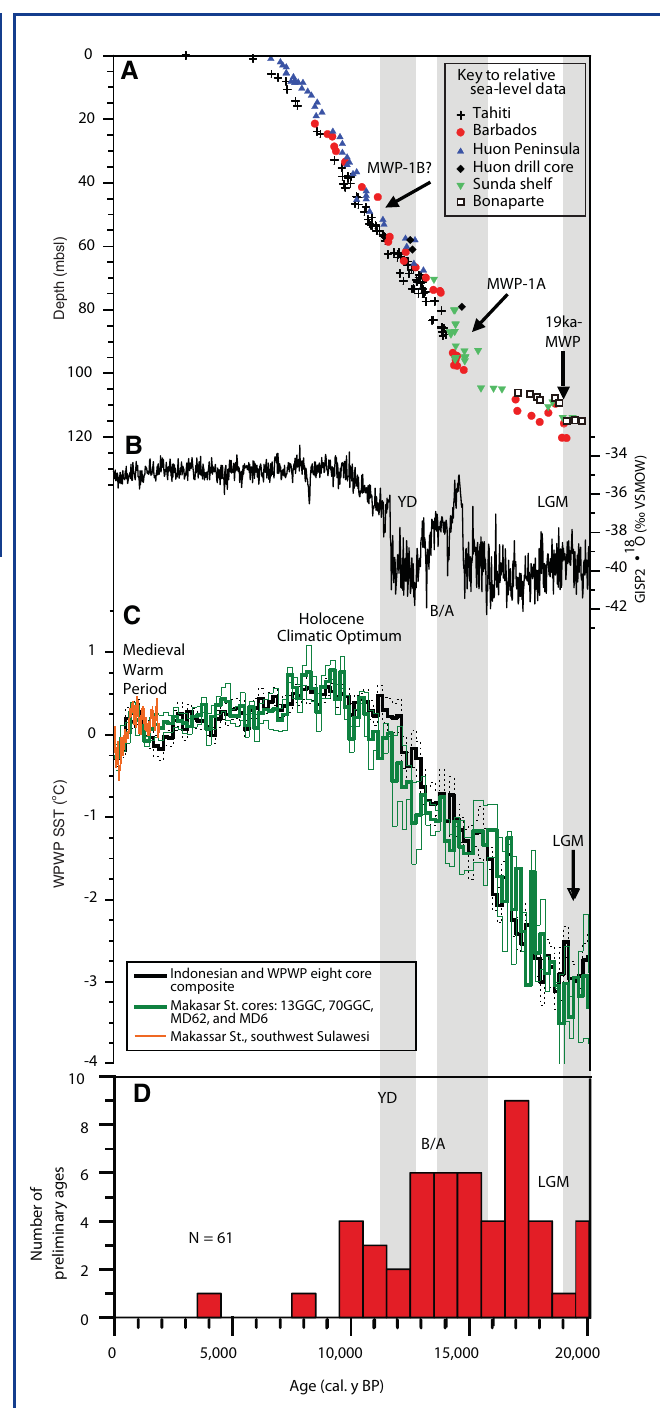
Age (cal. Figure 12. Comparisons of preliminary dating results and previously published sea-level and climatological data. [A] Previously published data on relative sea level from 20 cal k. y. BP through present. MWP= meltwater pulse. [B] GISP2 (cid:2) 18 O proxy for temperature over Greenland. [C] Sea-surface temperature variation in the Western Pacific Warm Pool (WPWP) (Linsley et al., 2010). [D] Histogram showing preliminary dating results on core catcher samples. Age distribution clearly indicates that the recovered fossil coral reef cores cover key intervals of interest for sea-level changes and environmental reconstruction, including the last glacial maximum (LGM), Bölling-Alleröd (B/A), and Younger Dryas (YD). Sources of data: Tahiti = Bard et al., 1996, 2010; Huon Peninsula = Chappell and Polach, 1991; Edwards et al., 1993; Huon drill core = Cutler et al., 2003; Sunda shelf = Hanebuth et al., 2000; Barbados = Fairbanks, 1989; Bard et al., 1990; Bonaparte = Yokoyama et al., 2000b; 2001a; DeDeckker and Yokoyama, 2009. GISP2 = Stuiver and Grootes, 2000.